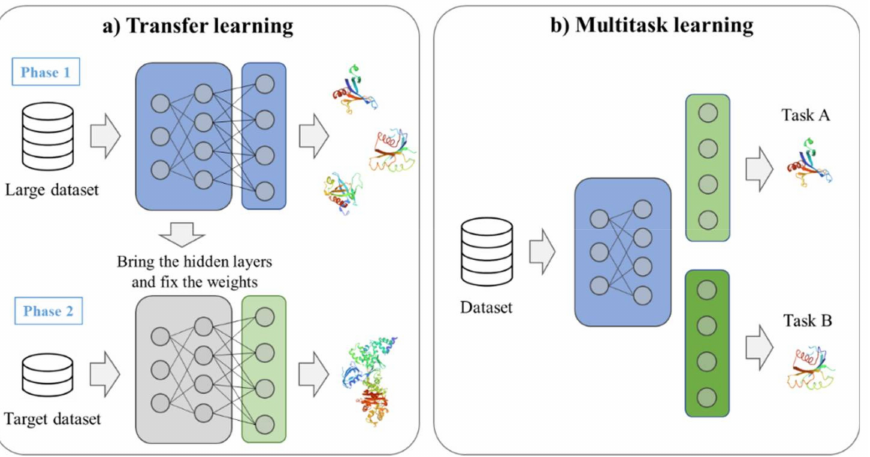
Figure 8. Simple example of transfer learning and multi-task learning. ( a ) Transfer learning ( b ) Mul- titask